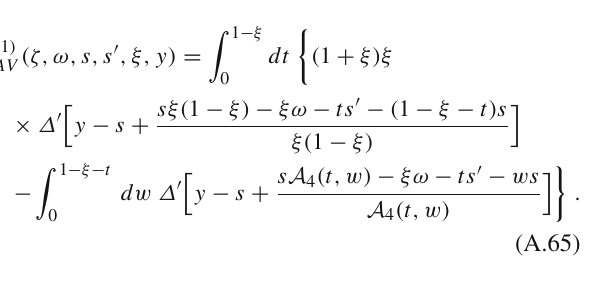
Fig. 9 The pictorial representation of the regularized photon self- energy in Eq. (60), with the external legs amputated. The thick lines are the renormalized propagators of i) the fermion and antifermion pair and ii) the incoming photon, while the thin one is the free photon prop- agator. The full dot represents the renormalized interaction vertex